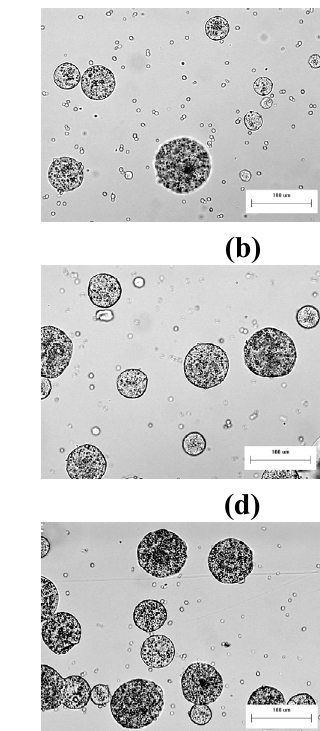
Figure 1. Photographs of (a) free yeast cells, (b) blank gellan gum microspheres, (c) encapsulated yeast cells in gellan gum microspheres and re-used yeast-gellan gum micro-bioreactors after the (d) first, (e) second and (f) tenth fermentation